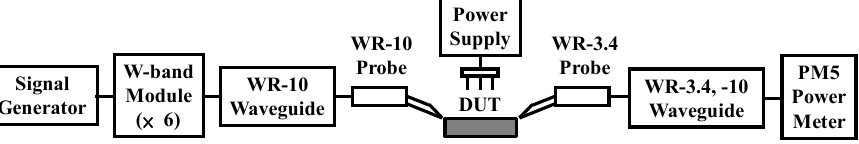
( b ) Figure 7. Measured output power at the output frequency of 273 GHz. ( a ) Output power versus input power; ( b ) output spectrum (after frequency down-conversion, using a harmonic mixer). Table 1. Comparison of active frequency multipliers reported in H -band. Reference